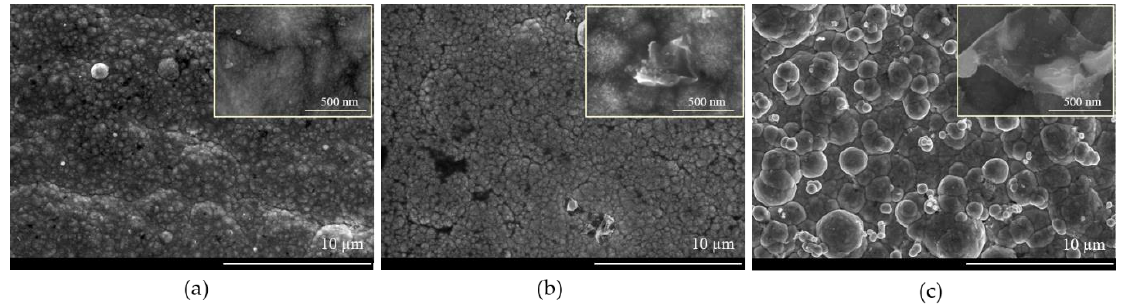
Figure 3. SEM micrographs of samples: ( a ) NiSn-rGO-P1, ( b ) NiSn-rGO-P2 and ( c ) NiSn-rGO-P3.